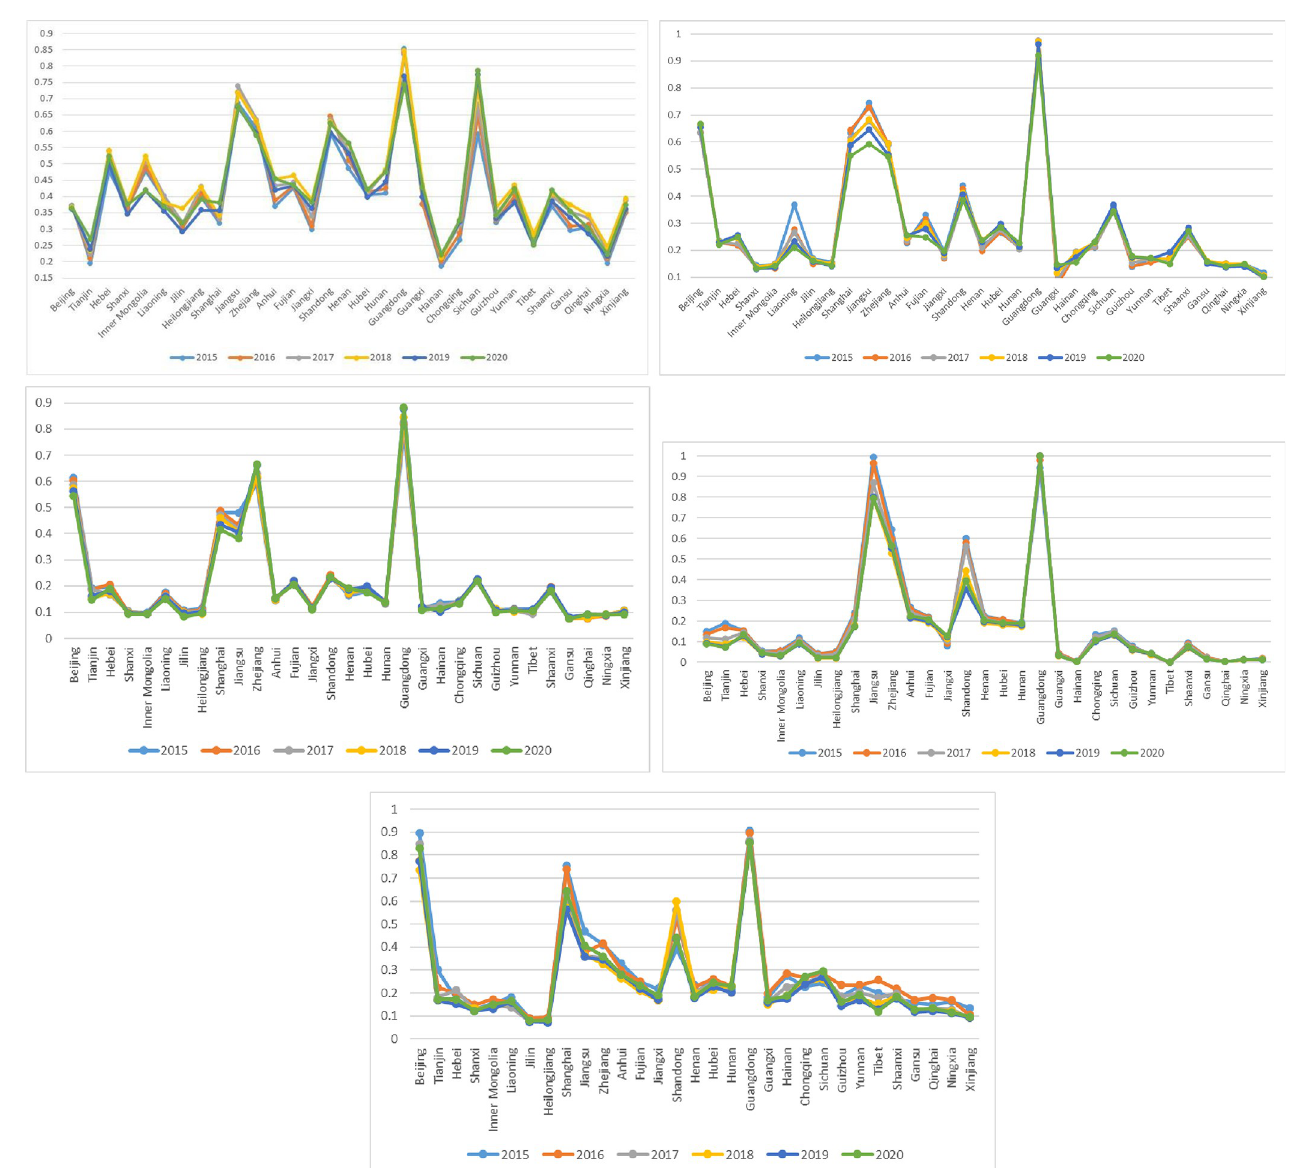
Fig 6. The detailed performance of 31 regions from 2015 to 2020. (a) Digital infrastructure performance of 31 provincial level regions from 2015 to 2020. (b) Integrated development performance of 31 regions from 2015 to 2020. (c) Social benefits performance of 31 regions from 2015 to 2020. (d) Innovation ability performance of 31 regions from 2015 to 2020. (e) Electronic-commerce performance of 31 regions from 2015 to 2020.